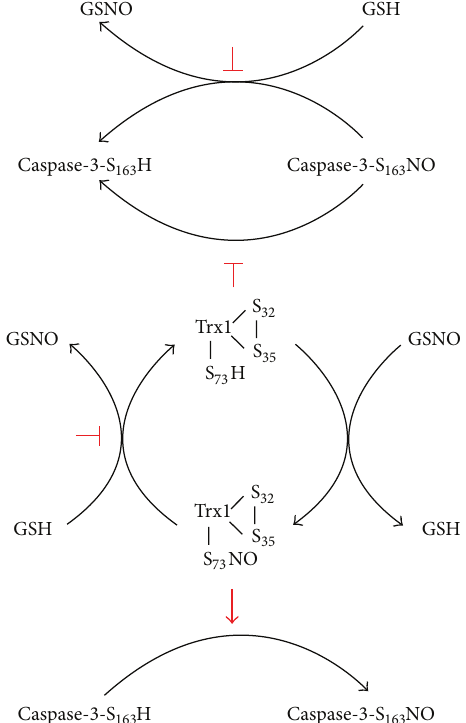
Figure 2: The proposed mechanism for the formation of hyper- S-nitrosylation of caspase-3. Under nitrosative stress, Trx1-S 2 can be nitrosylated to SNO-Trx1-S 2 , which further transnitrosylates caspase-3 to SNO-caspase-3. Both SNO-caspase-3 and SNO-Trx1- S 2 may become insufficiently denitrosylated by GSH and Trx1-(SH) 2 due to their depletion under the oxidative stress in RA-FLS, which further enhances the accumulation of SNO-caspase-3 and SNO- Trx1-S 2